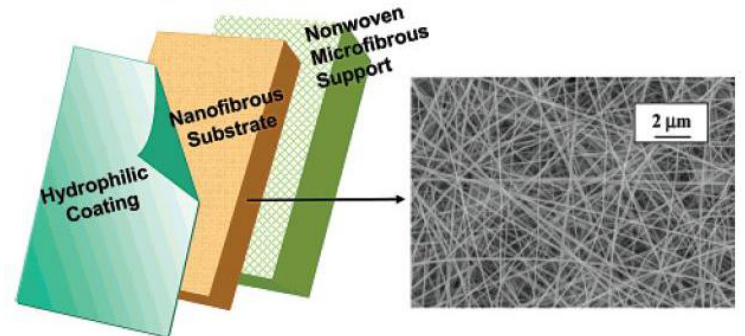
Figure 8. Schematic structure of the UF TFC electropun nanofibrous membrane (left) and representative SEM image of electrospun PVA midlayer (right)